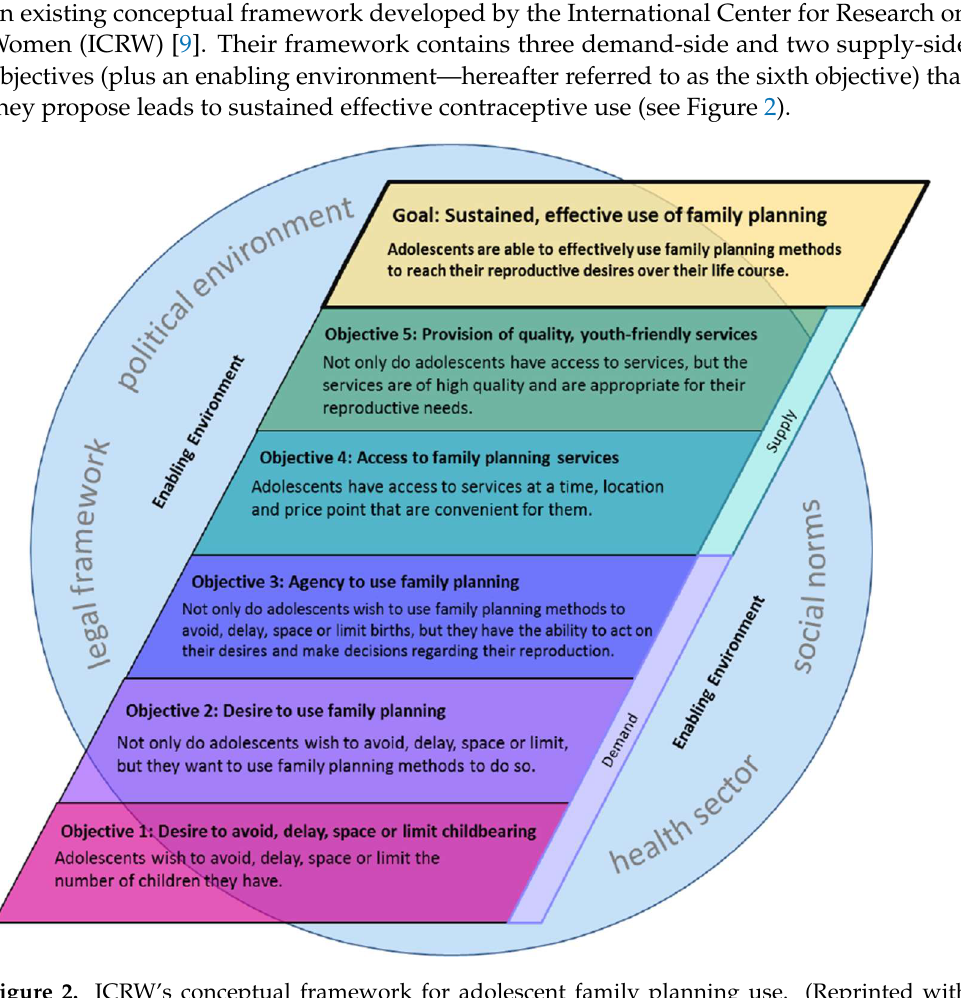
Figure 2. ICRW’s conceptual framework for adolescent family planning use. (Reprinted with permission from ref [9]. Copyright 2014 the International Center for Research on Women).